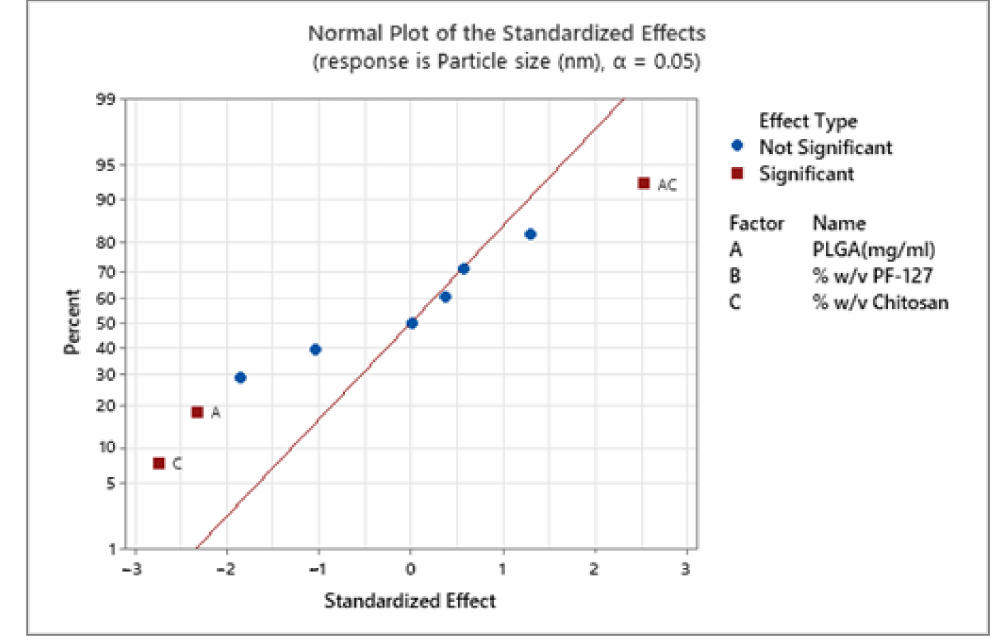
Figure 1. Effect of factors (PLGA, PF-127 and chitosan) on the particle size of chitosan-coated PLGA nanoparticles. The blue points represent the insignificant factors, and the red points represent significant